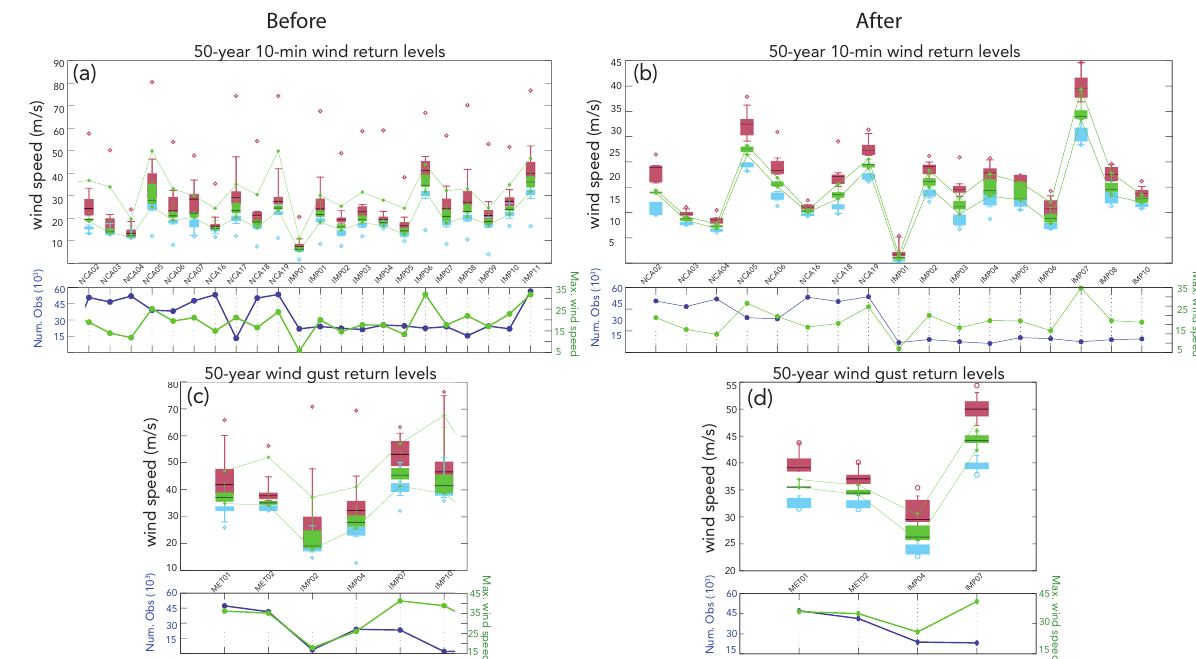
Figure 8. Top ( a , b ): box-whiskers plots of 50-year 10-min wind return values at each site within the dataset for experiments that succeeded tests MD1 and MD2 (left) and after all filters (MD1-MD6) were applied (right); green boxes represent the frequency distribution of the 10-min wind return levels over all experiments; the 10th, 25th, 50th, 75th and 90th percentiles are indicated with whiskers; the 50th percentile (median) is highlighted with a dark green horizontal line in each box; red (blue) box-whiskers represent the frequency distribution of the upper 95% (lower 5%) confidence limits of each successful experiment; red (blue) dots in the top panel stand for the maximum (minimum) values of the upper (lower) confidence intervals. The time series in the panels below represent the number of observations (dark blue) and maximum wind speed (green) recorded at the corresponding site represented in the left and right y axes, respectively. Note the different scales in the right and the left panels. Bottom ( c , d ): As above but for the wind